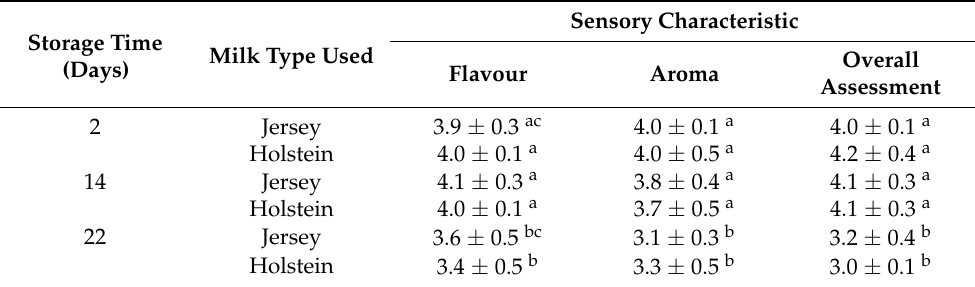
Table 5. Evaluation of the sensory characteristics of traditional-type Greek yoghurts made from Jersey or Holstein Friesian milk during storage at 4 ◦ C. Sensory Characteristic Storage Time Milk Type Used Overall (Days) Flavour Aroma Assessment 2 Jersey 3.9 ± 0.3 ac 4.0 ± 0.1